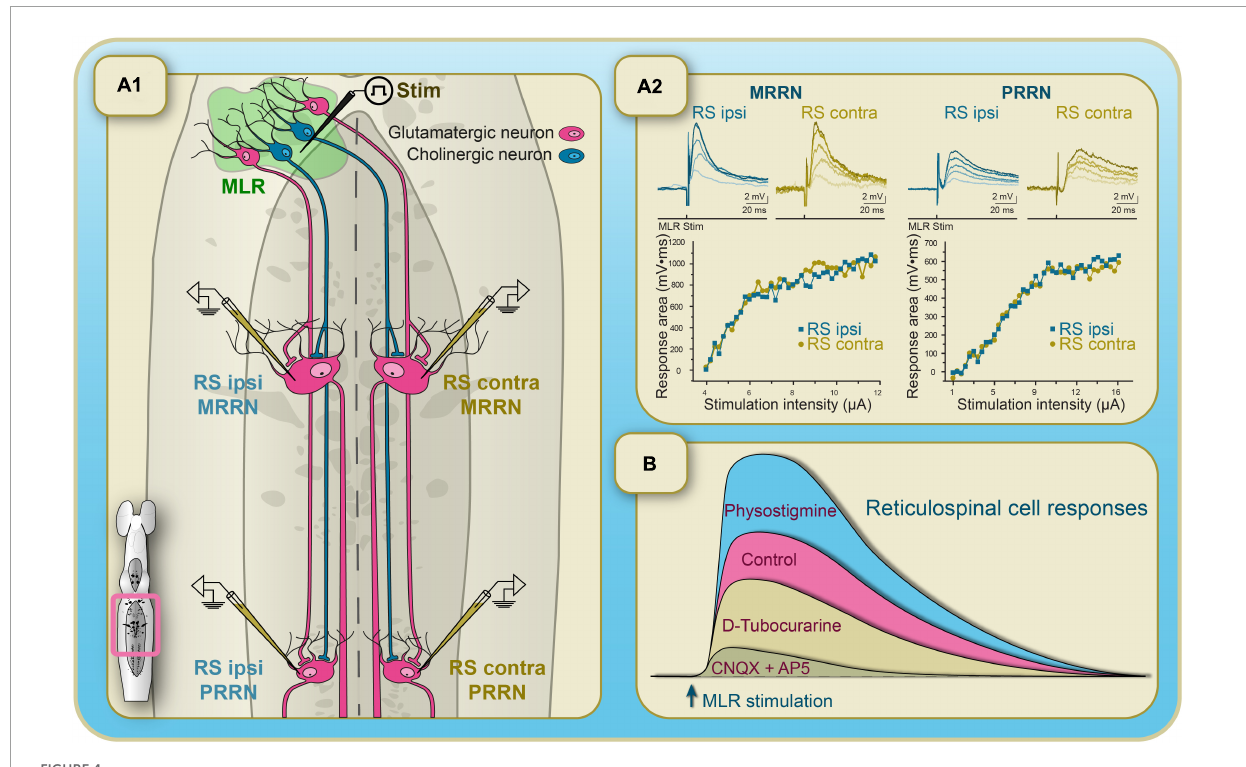
FIGURE4 A unilateral stimulation of the MLR in lampreys elicits coordinated and symmetrical swimming movements on both sides. Physiological experiments showed that the MLR on one side of the brainstem provides highly symmetrical glutamatergic and cholinergic inputs to paired, giant RS cells from opposite sides of the brainstem. Anatomical experiments confirm the presence of bilateral projections from the MLR to RS cells. (A1) Diagram of the hindbrain showing the bilateral connections between the MLR and paired, giant RS cells as well as the position of the electrodes for the electrophysiological experiments. (A2) Left side: the MLR on one side is stimulated at increasing intensities and the synaptic responses are recorded in paired, giant RS cells located in de pontine reticular formation (MRRN) on opposite sides of the brainstem. Note that the responses are remarkably similar on both sides. Right side: Same as on the left side, but for paired large RS cells in the bulbar reticular formation (PRRN). (B) Schematized illustration of the subthreshold synaptic responses elicited in reticulospinal neurons by stimulation of the MLR. Glutamatergic and cholinergic transmission were blocked or potentiated sequentially by adding different pharmacological agents. The EPSPs were increased under physostigmine, an inhibitor of the re-uptake of acetylcholine. The EPSPs were significantly decreased under D-tubocurarine, a nicotinic receptor antagonist, and were further decreased by the addition of a mixture of CNQX/AP5, glutamatergic receptors antagonists. A small response from unknown origin remained. Adapted from Brocard et al.